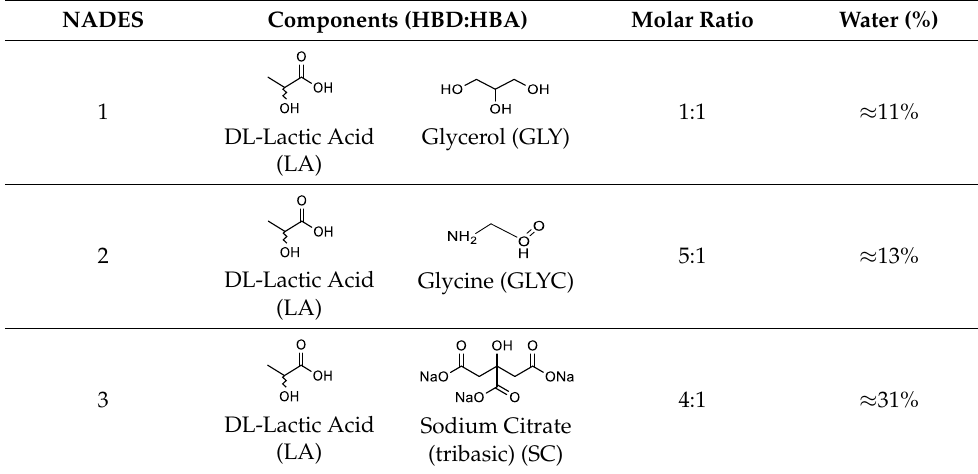
Table 1. NADES composition, molar ratio used for synthesis, water percentage, and abbreviation used for each eutectic mixture.